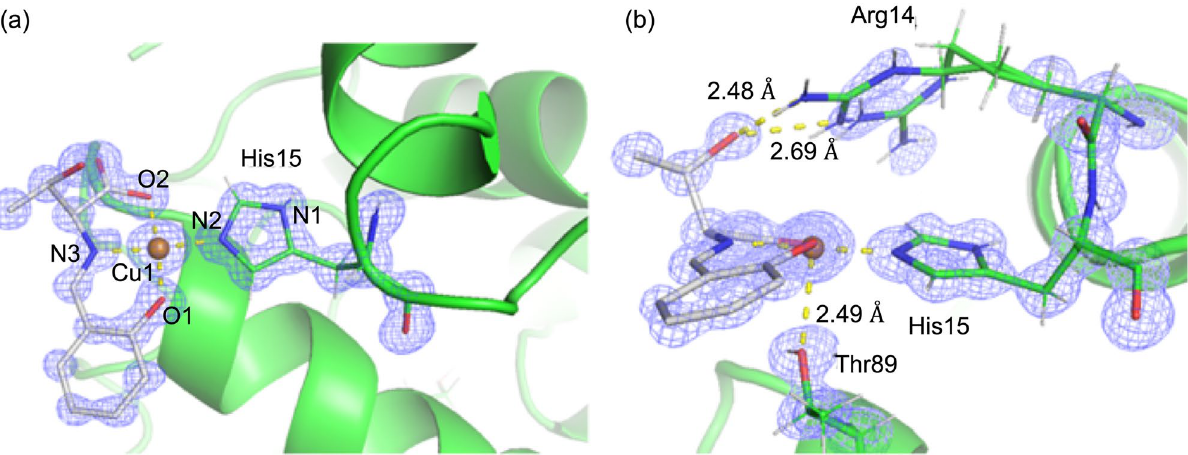
Figure 9. ( a ) Top view and ( b ) side view of crystal structures of CuST@lysozyme around the Cu(II) center. The 2 F o − F c electron-density map is contoured 1.0 σ. R work / R free = 0.1120/0.1291. Selected bond lengths (Å) and angles (°): Cu1–O1 = 1.994, Cu1–O2 = 2.035, Cu1–N2 = 1.979, Cu1–N3 = 1.983, O1–Cu1–N3 = 91.87,